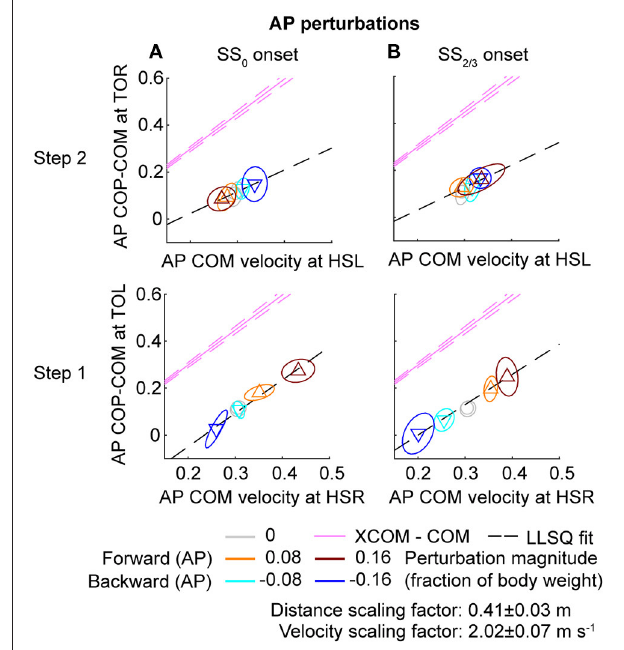
FIGURE 9 | Relation COM velocity and COP location in comparison with the XCOM, following AP perturbations. (A) The AP COP location relative to the COM, at TOL (step 1) and TOR (step 2) as a function of the AP COM velocity at the preceding heel strike. Perturbation onset was at SS 0 . (B) Same as (A) , but for perturbation onset at SS 2 / 3 . The pink line corresponds to the XCOM position relative to the COM, as a function of the COM velocity. It has slope ω − 1 0 and zero intercept. The pink dashed lines indicate the between-subject standard deviation of the XCOM, based on the differences in leg length between subjects. The black dashed line is a linear least squares fit to the data. Triangles show subject-averages and indicate the perturbation direction. Ellipses represent the subject-standard deviation. Colors indicate the different perturbation magnitudes. Data is shown